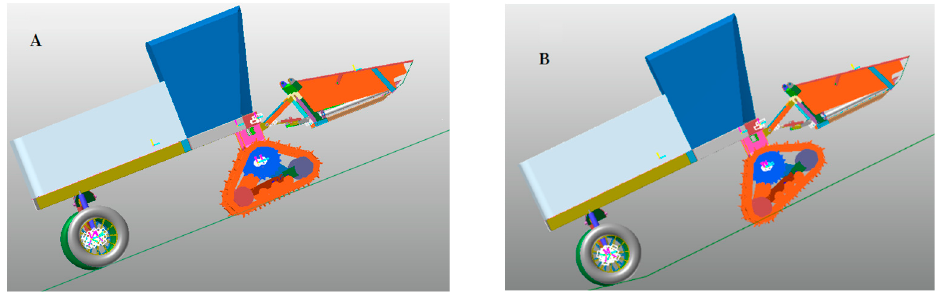
Figure 16. Uphill simulation. ( A ) Stable uphill state; ( B ) Unstable uphill state.